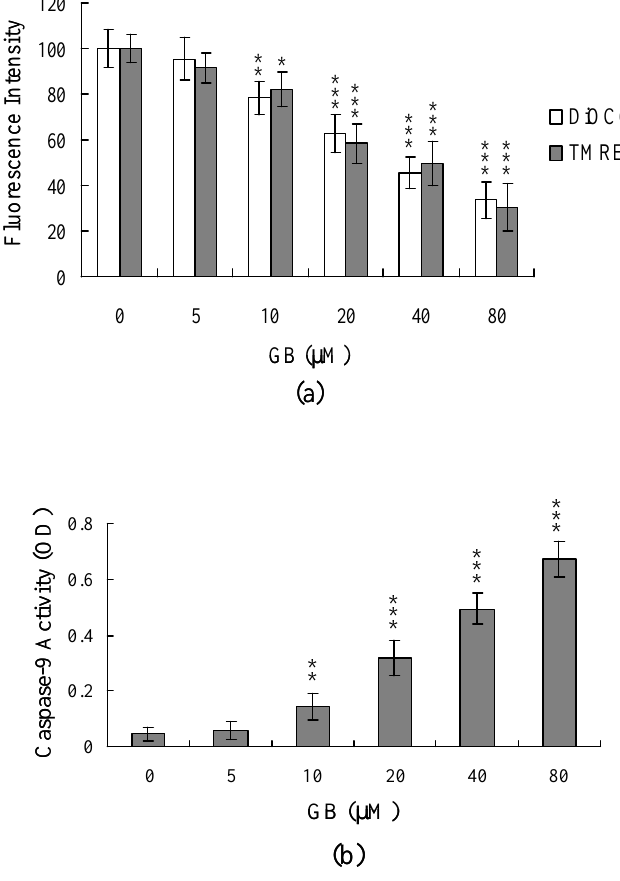
Figure 4. Loss of MMP and activation of caspase-9 and -3 by ginkgolide B of MCF-7 cells. Cells were incubated with or without various concentrations of ginkgolide B (GB) for 24 h. (A) Mitochondrial membrane potential (MMP) changes were analyzed using 40 nM DiOC6(3) or 1 µ M TMRE. (B) Caspase-9 activities were assayed using the